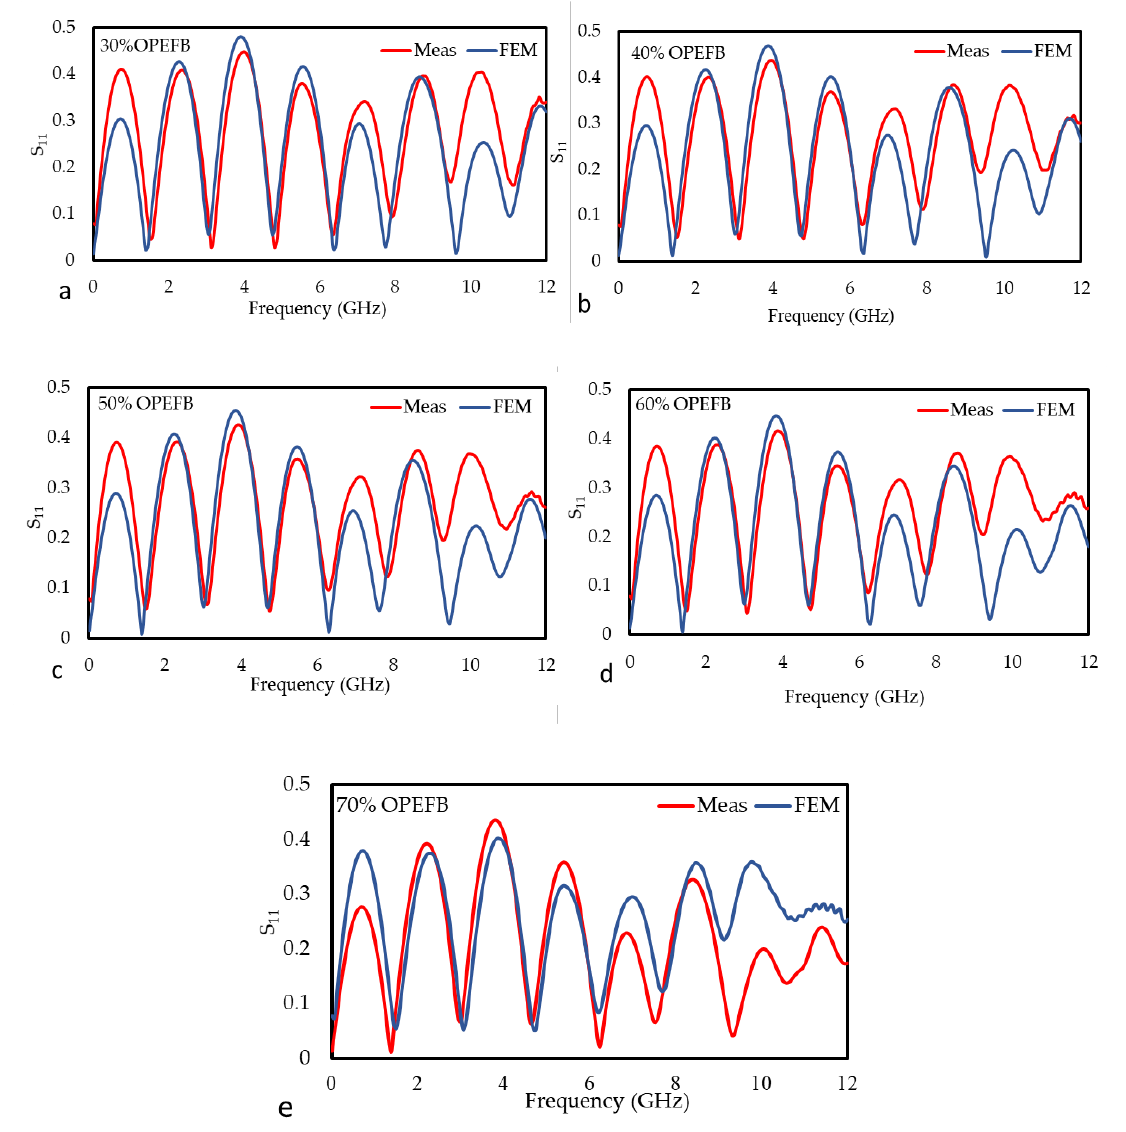
Figure 15. Variation in the magnitude of S 11 for the different OPEFB/PLA composites ( a ) 30 wt%, ( b ) 40 wt%, ( c ) 50 wt%, ( d ) 60 wt%, and ( e ) 70 wt% OPEFB for both the measurement and FEM simulation.